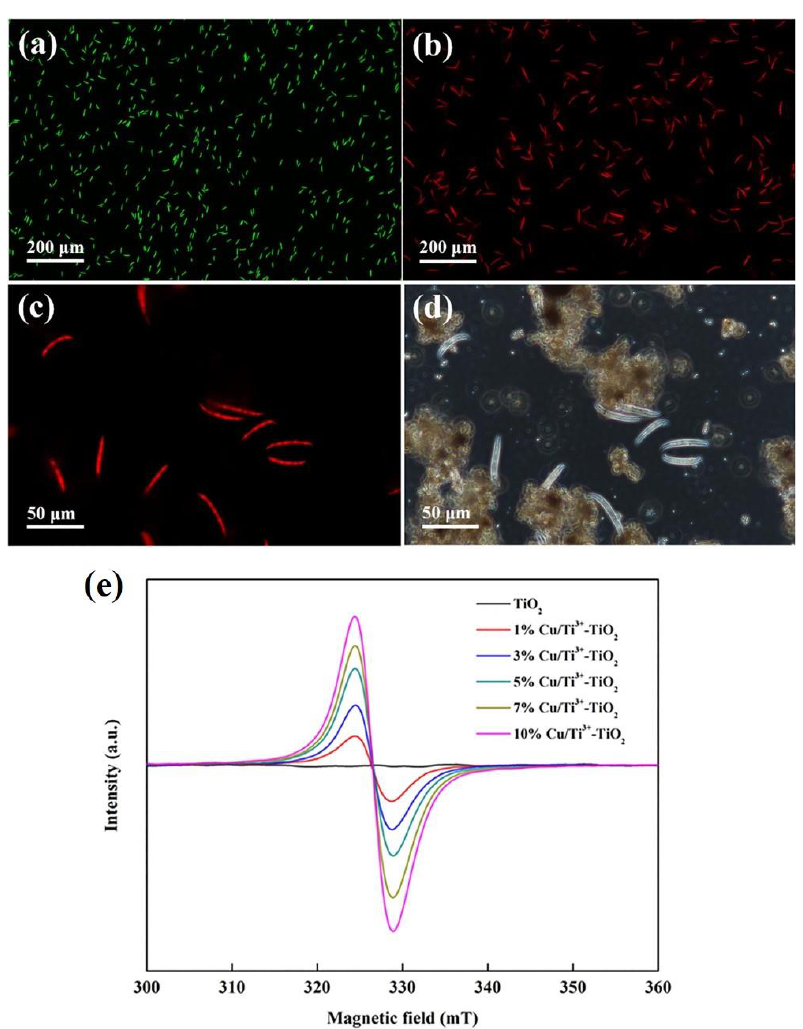
Figure 6. Fluorescent images showing cell viability of the F. graminearum macroconidia after illumination for 100 min: without photocatalyst ( a and b ) or treated with the 10% Cu / Ti 3 + –TiO 2 composite ( c and d ); ( b , d ) are the enlarged observations of macroconidia in ( a , c ). The cell was stained by CFDA-AM / propidium iodide and the live cells appear green, while the dead ones are red in the images. ( e ) is ESR spectrum of the pure TiO 2 and Cu / Ti 3 + –TiO 2 . Reproduced from